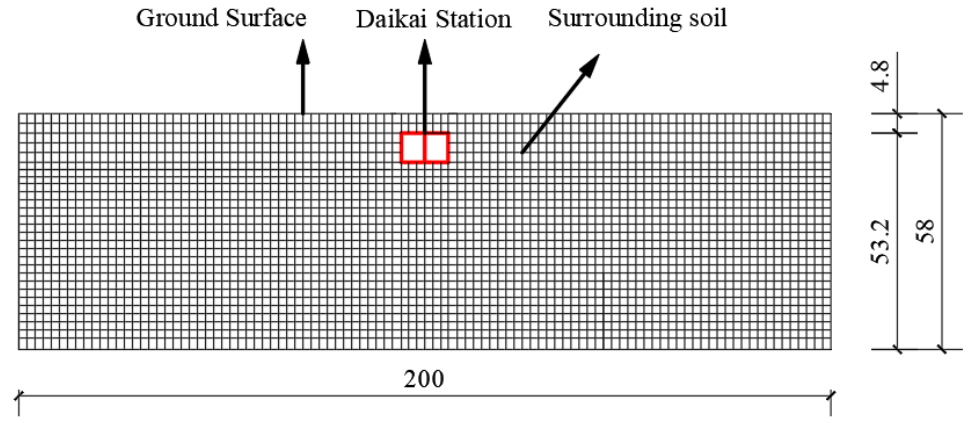
Figure 1. The stratum-station system FEA model (units in m).